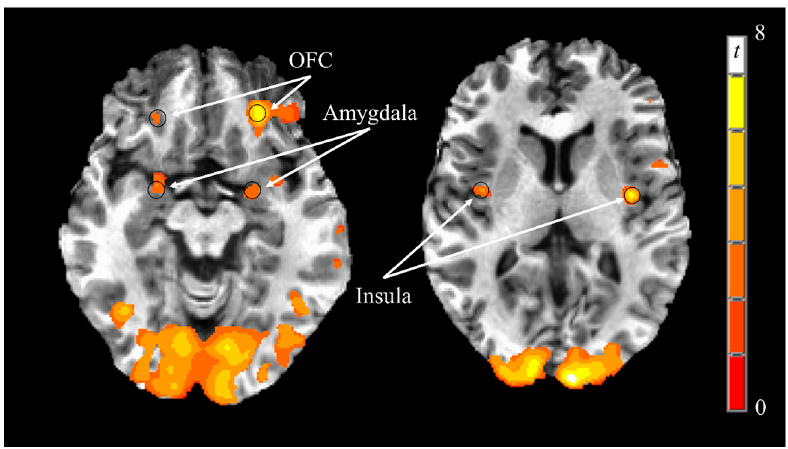
Figure 3. Visual representation of preprandial neural responses to visual food stimuli on Day 1. Greater responses to visual food stimuli vs. nonfood stimuli (PROC TTEST, SAS, Version 9.3; p < 0.005) were observed in the bilateral orbitofrontal cortex, amygdala, and insula. Black circles represent functional regions of interest with 3 mm radii within a priori brain regions of interest with known reward functions. Images are in the axial plane and left side of the figure corresponds to the right side of the body and vice versa. Display threshold: p < 0.005 and minimum cluster size of 123 voxels. Abbreviations: OFC, orbitofrontal